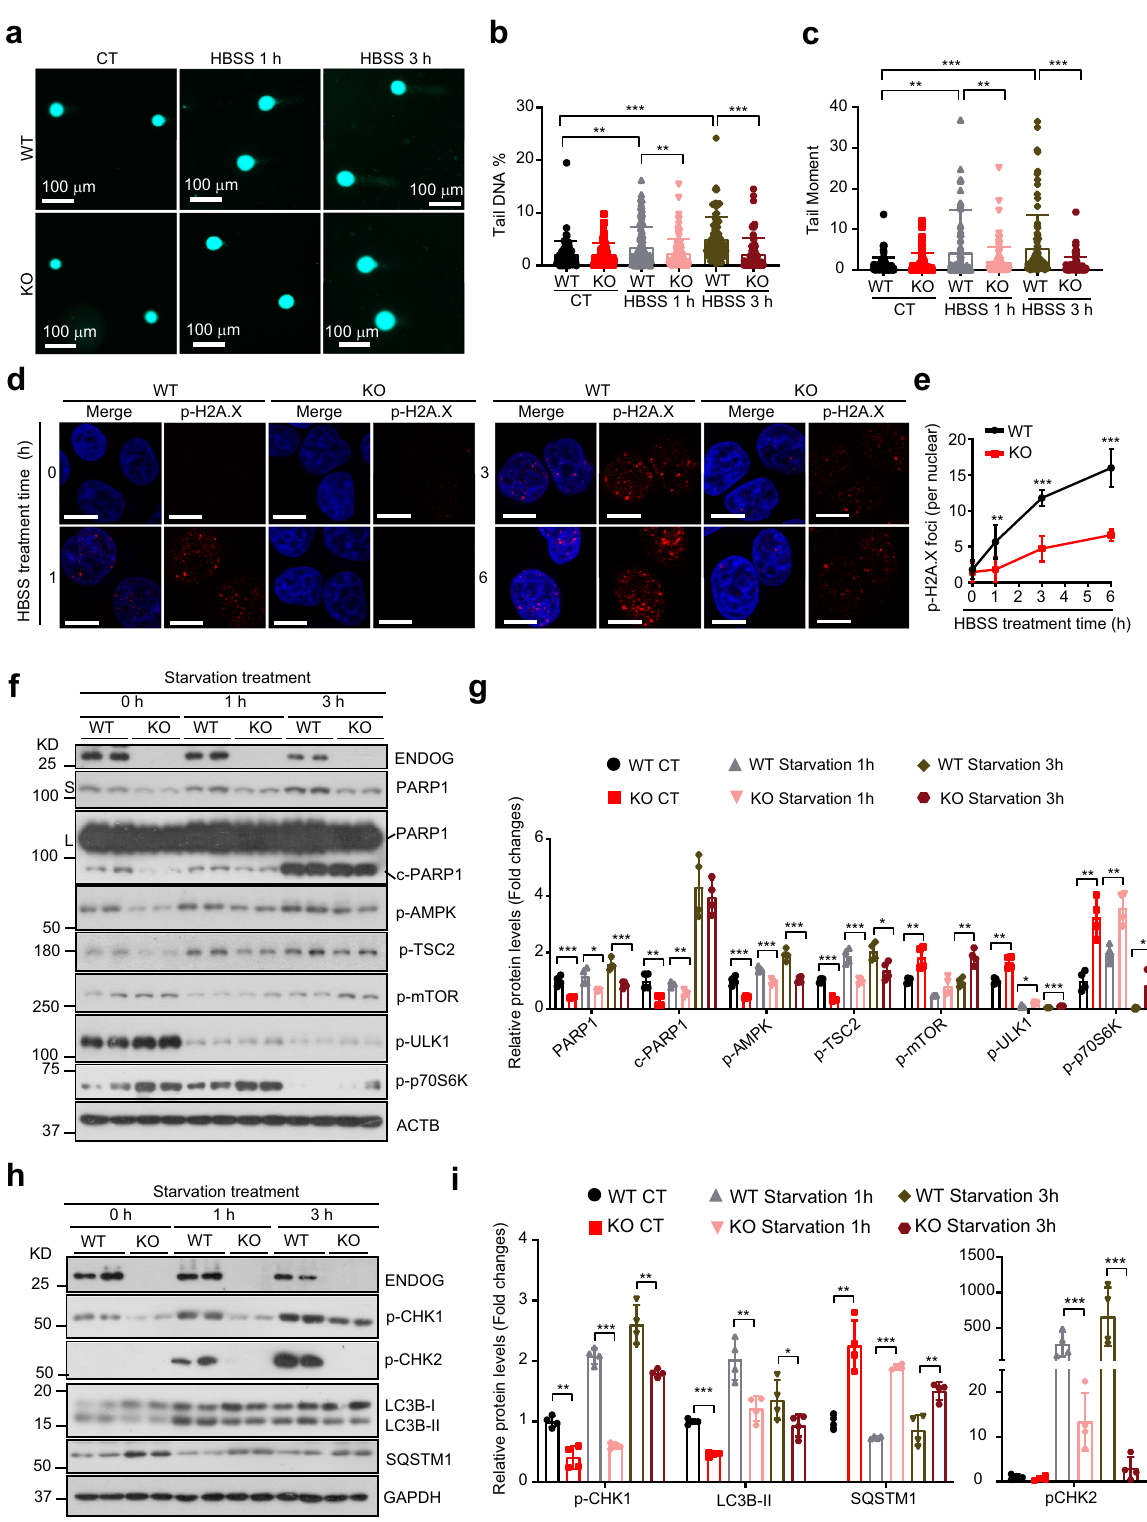
Fig. 5 Loss of ENDOG repressed the starvation-induced DNA damage and autophagy. a – c Representative images of comet assay in wild-type or ENDOG knockout L02 cells ( a ) and the quanti fi cation of tail DNA ( b ) and tail moment ( c ) (starvation treated for 1 or 3 h; n = 75 – 100 independent cells; data are presented as mean values ± SD, ** p < 0.01, *** p < 0.001). d , e Representative imag e s of p-H2A.X foci ( d ) and quantitative results ( e ) in wild-type or ENDOG knockout (KO) L02 cells at the indicated time point after the starvation treatment (scale bar = 10 μ m, n = 50 independent cells; data are presented as mean values± SD; ** p < 0.01, *** p < 0.001). f – i Western blots and quantitative results of the indicated proteins in wild type or ENDOG knockout L02 cells following starvation treatment ( n = 4 independent samples; data are presented as mean values ± SD, * p < 0.05; ** p < 0.01; *** p < 0.001). Source data are provided as a Source data fi